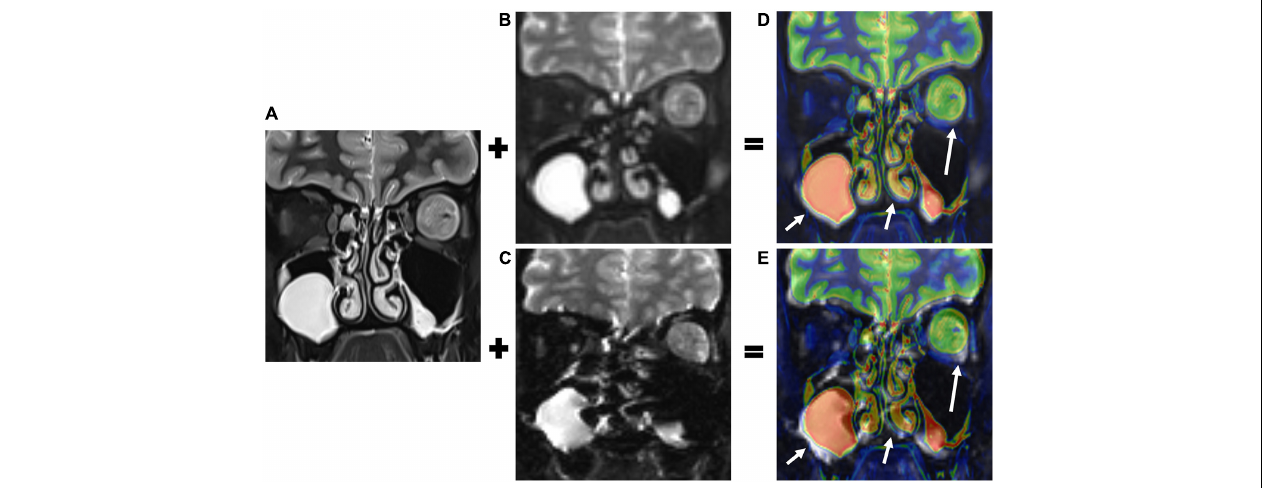
FIGURE 1 | T2-weighted imaging (T2WI, A ), b0 images of TGSE-PROPELLER-DWI (B) , and rs-EPI (C) were fused. Color- and gray-coated images were derived from the T2WI and the two DWI b0 images (D,E) , respectively. The T2WI and TGSE-PROPELLER-DWI b0 images matched well, showing the left orbital tumor (long arrows in D ) and ethmoid and maxillary sinuses (short arrows in D ). The T2WI and rs-EPI b0 images were mismatched due to geometric distortions in the corresponding structures (arrows in E ).